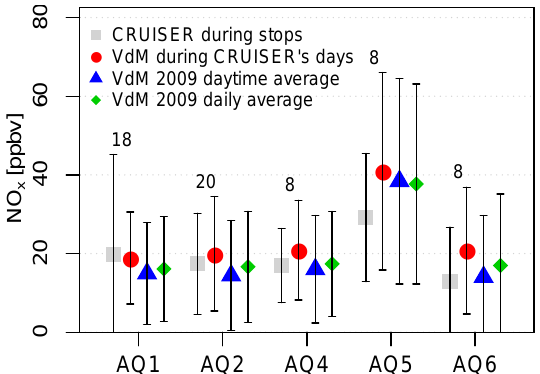
Figure 2. Comparison of CRUISER’s average pollution levels dur- ing time it was parked next to VdM’s AQ monitoring sites (gray squares), VdM’s average levels during CRUISER’s measurement days (red circles), VdM 2009 daytime annual averages (blue trian- gles) and VdM 2009 daily annual averages (green diamonds) for seven relevant pollutants. Whiskers denote one standard deviation. Number above whiskers denotes number of visits to